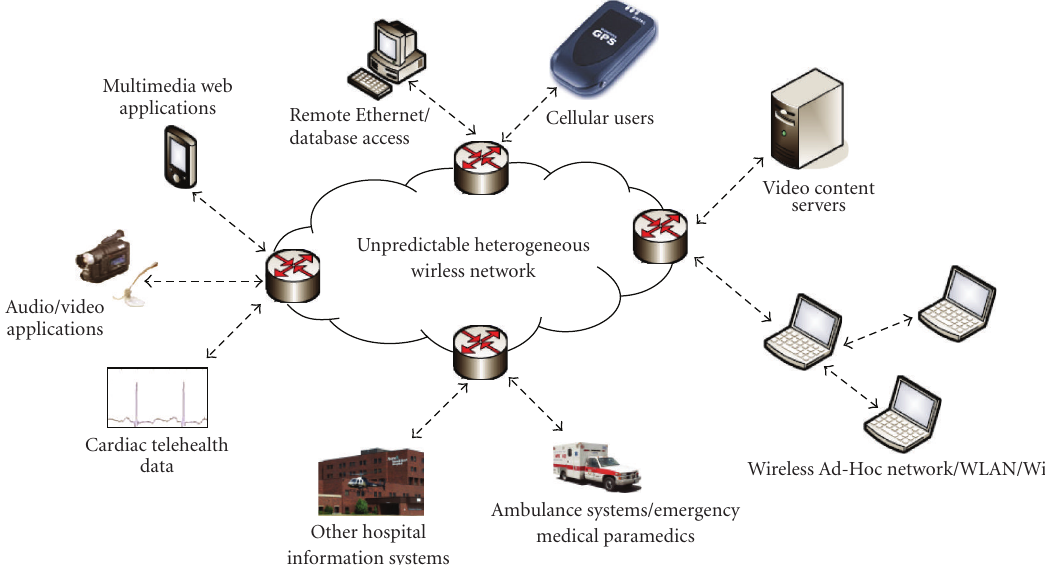
Figure 2: Unpredictable xG network over which the data has to be reliably sent to the remote health